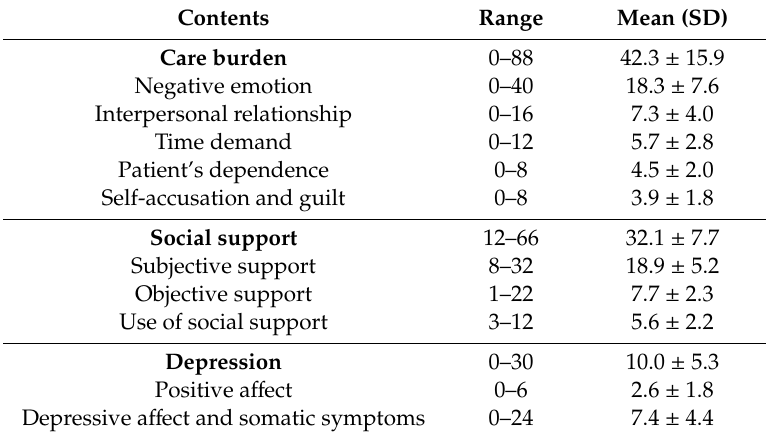
Table 2. Description of social support, care burden and depression scores ( n =